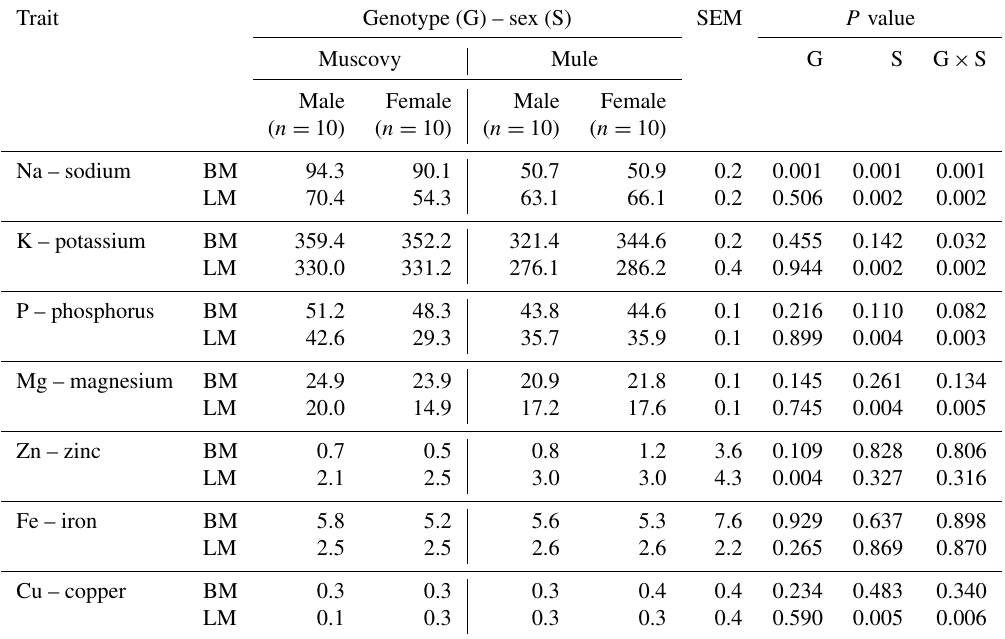
Table 3. Content of some minerals in milligrams per 100g of breast or leg meat from ducks of different genotypes.